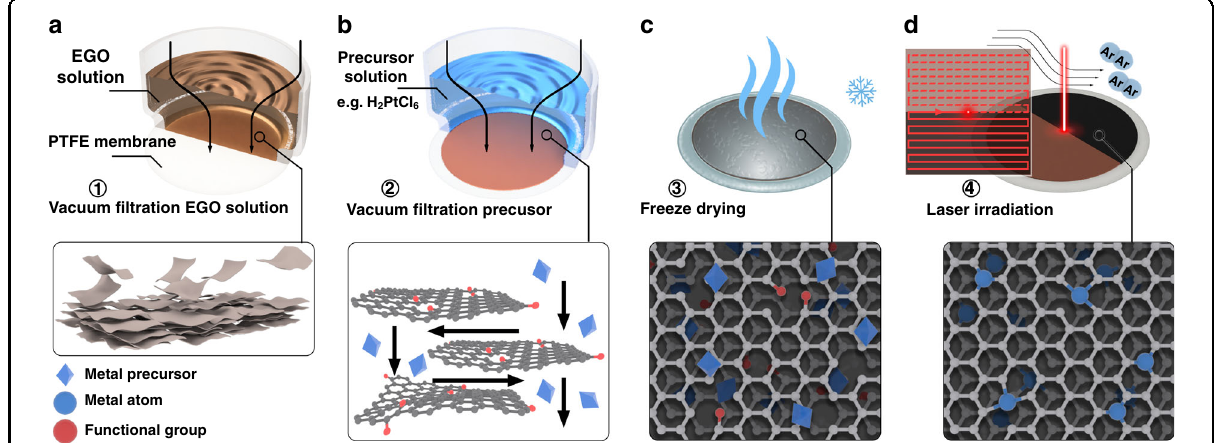
Fig. 1 Schematic illustration of the formation of Pt-LrEGO. a Preparation of EGO fi lm from 1.0 mg mL − 1 EGO solution through vacuum fi ltration; b metal precursor fi lter through the EGO fi lm and followed by ( c ) immediate freeze in liquid nitrogen and freeze-drying; d direct 1064 nm laser irradiation of the Pt-EGO to form Pt-LrEGO, inset shows the schematic of the parallel laser scanning path across the EGO fi lm, the laser beam spot size was 1 mm in diameter and overlap ratio between the tracks was